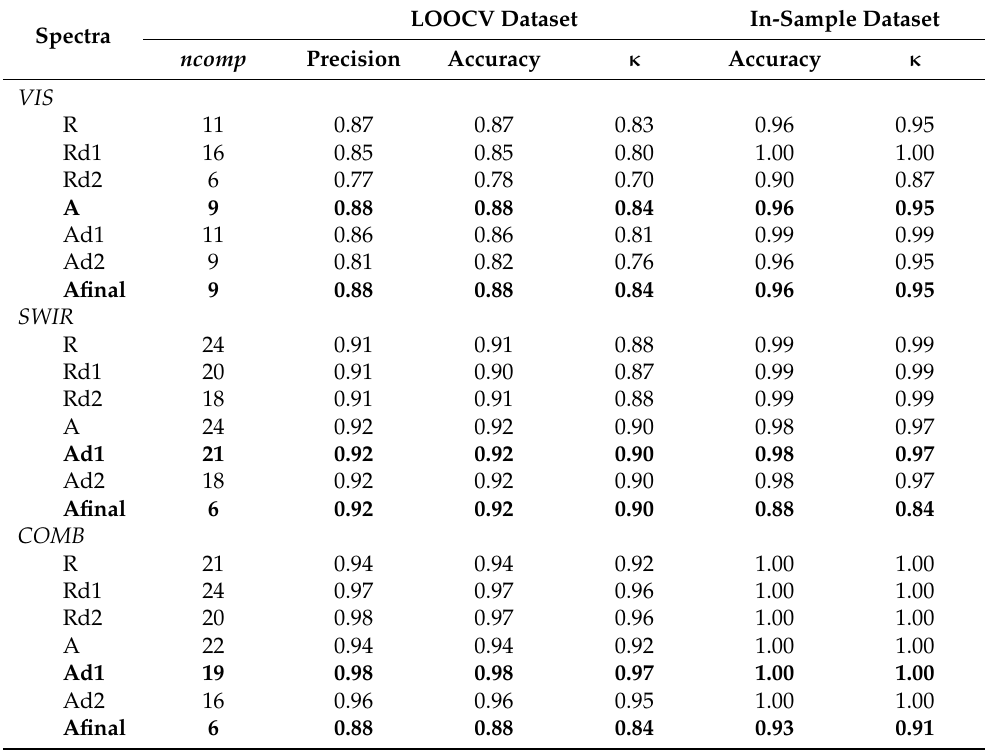
Table 2. Partial least squares discriminant analysis (PLS-DA) classification accuracy and coefficient of agreement (Kappa, κ ) from visible (VIS), short-wave infrared (SWIR) and combination VIS and SWIR (COMB) hyperspectral sensors to differentiate bovine and ovine hearts, kidneys, livers, and lungs using various pre-processing methods on the leave-one-out cross validation (LOOCV) and in-sample